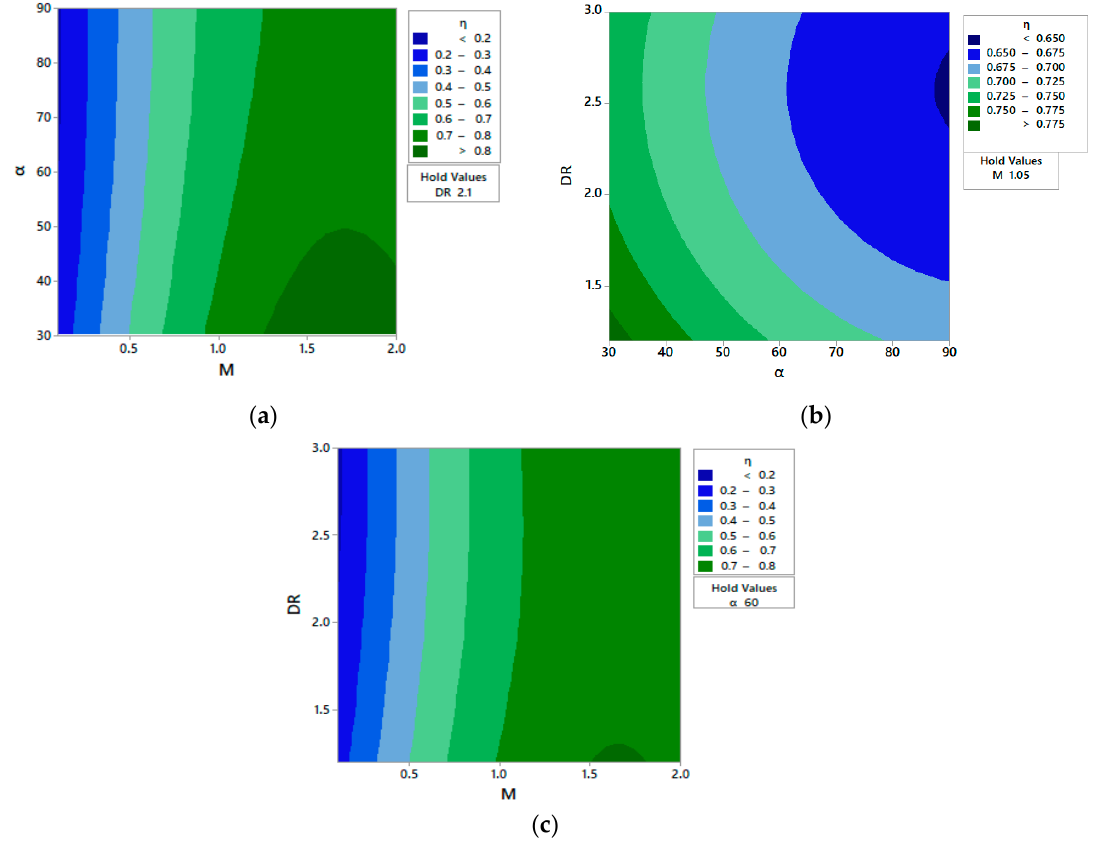
Figure 11. Contour plots of the averaged AFCE for all the parameters. ( a ) Blowing ratio for different injection angles at 𝐷𝑅 = 1.2 , ( b ) Injection angle for different density ratios at 𝑀 = 1.0 and ( c ) Blowing ratio for different density ratios at 𝛼 = 30 .